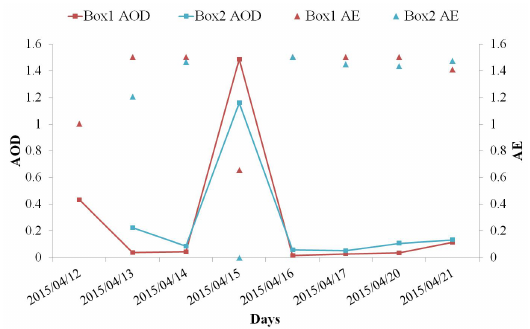
Figure 3. MODIS, AOD, and AE in the two boxes located in the city of Ulanqab and Zhangjiakou.